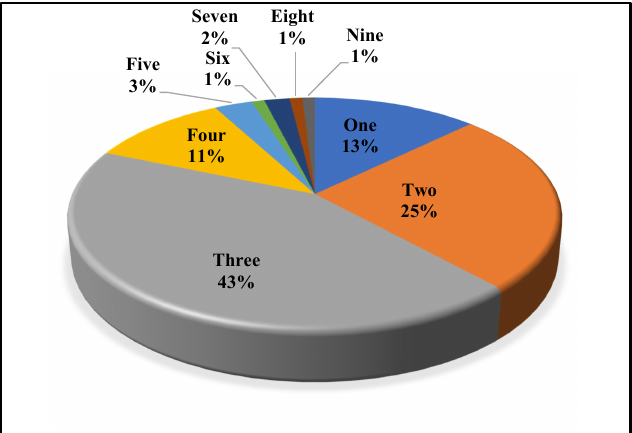
Figure 3. Number of authors per publication .